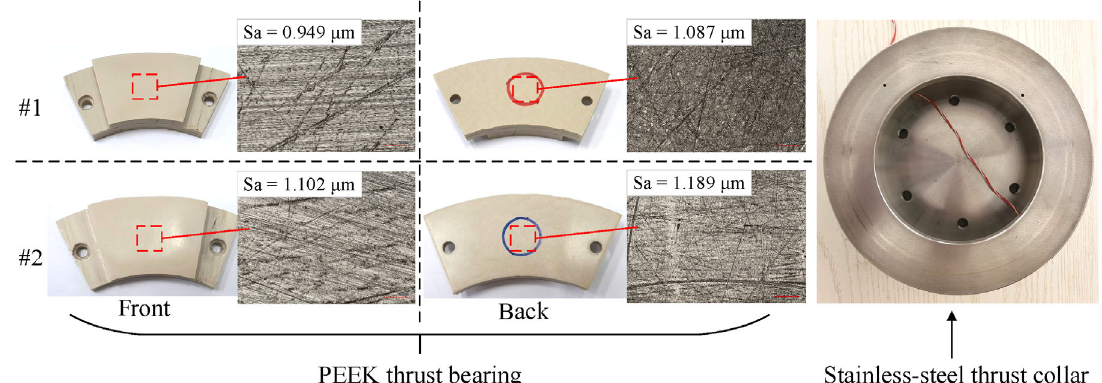
Fig. 21 Test bearings and thrust